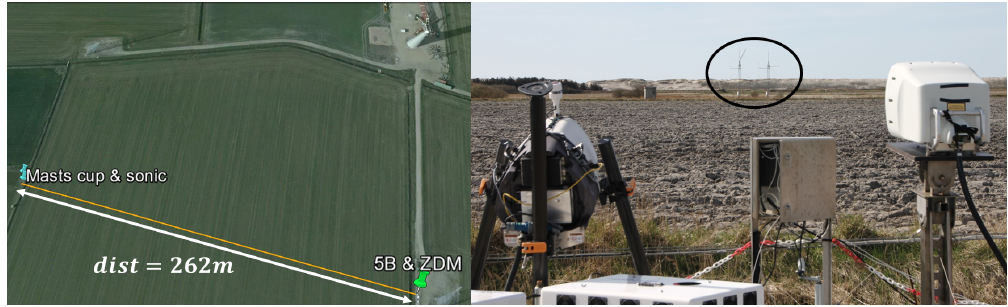
Figure 5. Calibration measurement setup at DTU Wind Energy’s test site, Høvsøre, Denmark. Left : Google Earth image; Right : the ZDM and 5B lidars.